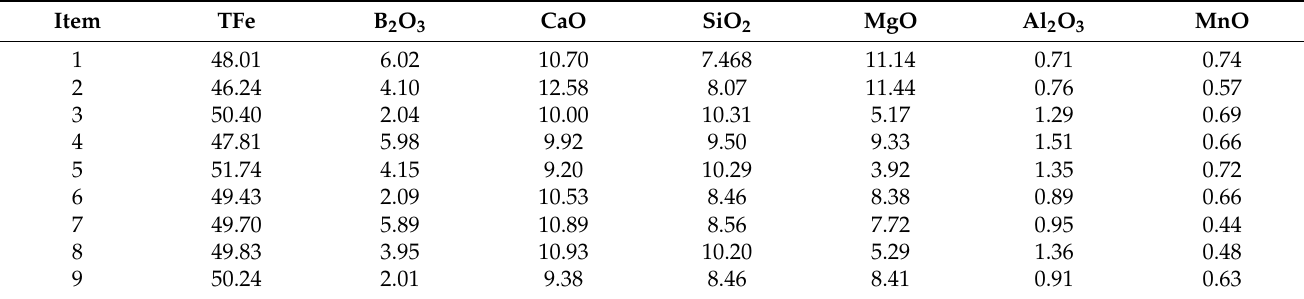
Table 10. Chemical composition of ludwigite sinters after reduction/wt%.